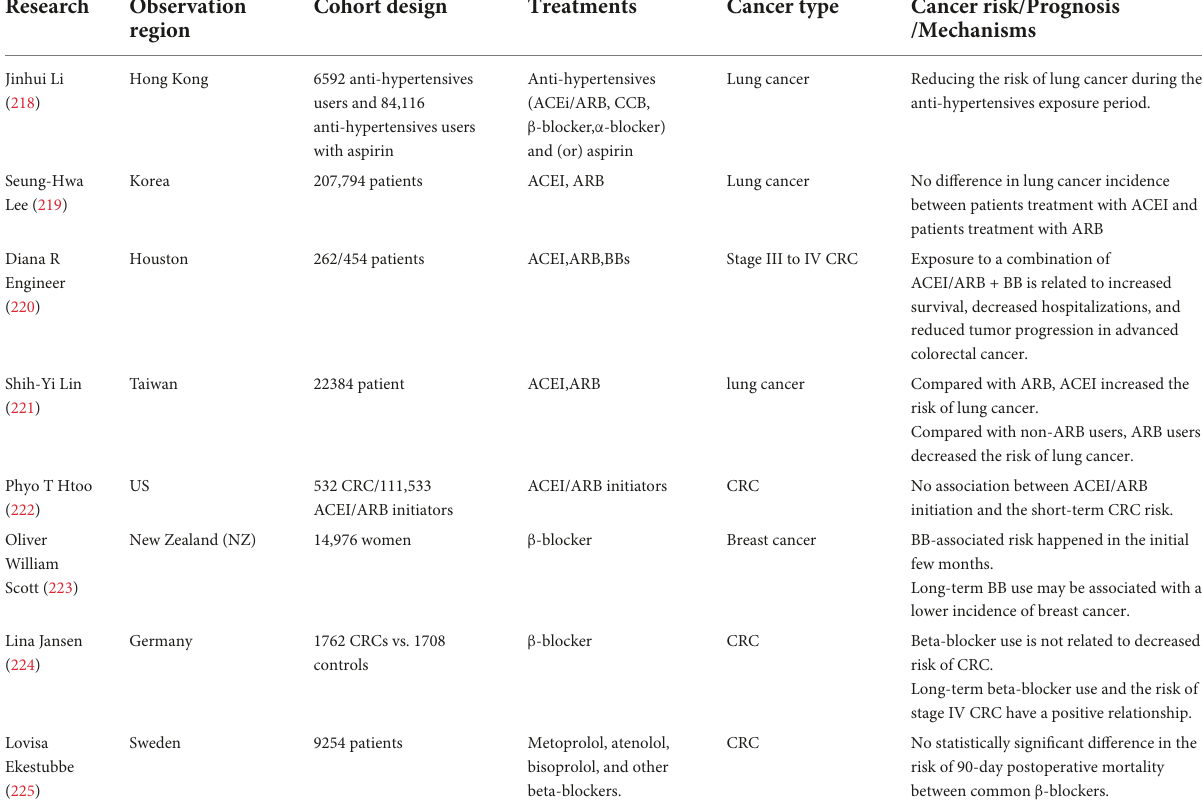
TABLE 3 Cardiovascular disease treatment and cancer risk.